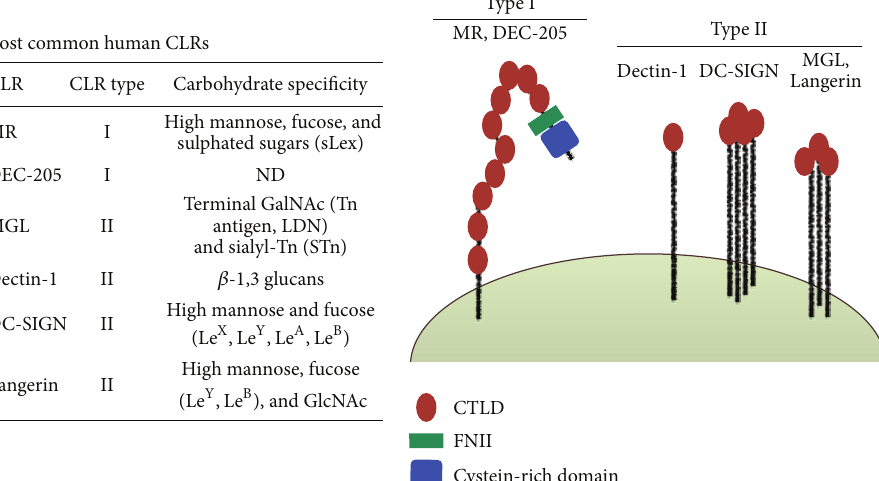
Figure 1: Schematic representation of type I and type II C-type lectins and lectin-like receptors. Type I CLRs (MR, DEC-205) are composed of a N-terminal cysteine-rich domain, a single fibronectin type II (FNII) domain, and 8–10 CTLDs all expressing CRDs. Type II CLRs (Langerin, DC-SIGN, MGL) or lectin-like receptors (Dectin-1) are composed of a single CTLD, an extracellular stalk region, a transmembrane region, and a N-terminal cytoplasmic tail with or without a signaling motif or proline-rich region. Langerin, DC-SIGN, MGL, and Dectin-1 express a CRD on their CTLD. CTLD, C-type lectin like domain; CLR, C-type lectin receptor; CRD, carbohydrate recognition domain; MR, mannose receptor; DC-SIGN, DC-specific ICAM3-grabbing nonintegrin; MGL, macrophage galactose type C-type